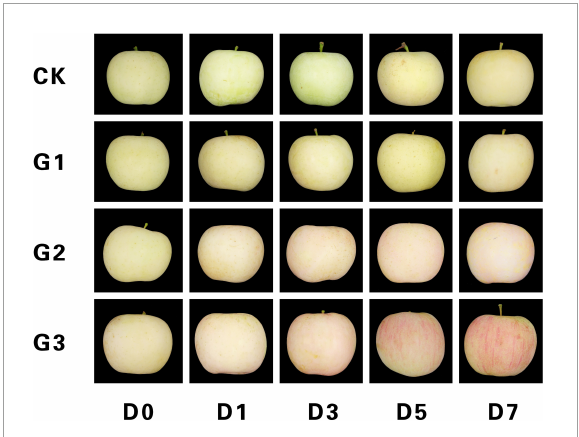
FIGURE1 Light-induced color formation of bagged apples under dark conditions. CK, No bag removal; G1, 1 day of natural light induction; G2, 2 days of natural light induction; G3, 3 days of natural light induction; D0, 0 day of dark treatment; D1, 1 day of dark treatment; D3, 3 days of dark treatment; D5, 5 days of dark treatment; and D7, 7 days of dark